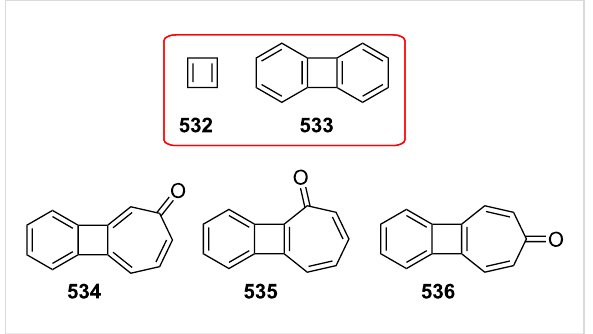
Figure 34: Possible three benzocyclobutatropones 534 – 536